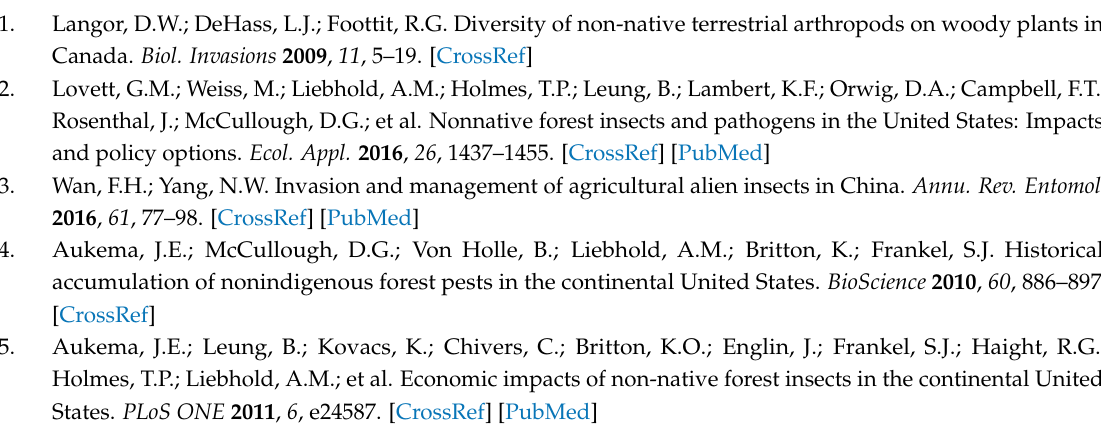
Table S1: Summary of Oobius agrili release data in Maryland by site from 2009–2015. Shown are year of release, number of releases, mean ± SE O. agrili per release, total number released, and the earliest and latest date of release. Bold type indicates sites surveyed for recovery, and asterisks indicate sites where O. agrili were